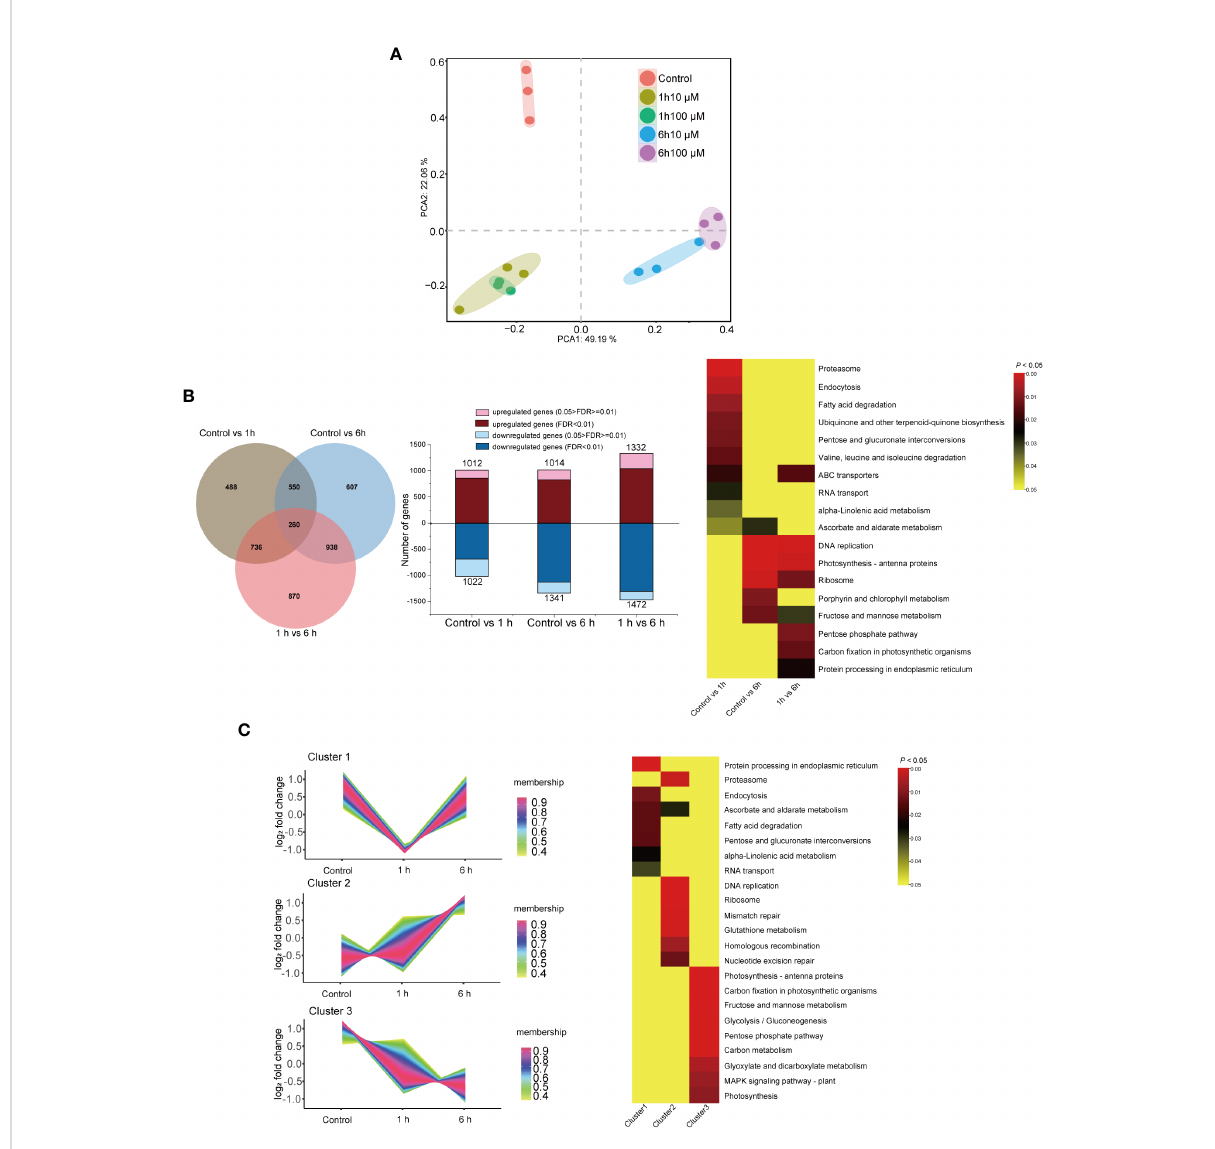
FIGURE 2 Transcriptional responses of Neoporphyra haitanensis to abscisic acid (ABA) treatment. (A) Principal components analysis (PCA) of the transcriptomic pro fi le of individual traits of N. haitanensis in response to ABA treatment. (B) A Venn diagram of differentially expressed genes (DEGs), the number of DEGs across treatments and a heatmap of signi fi cantly enriched pathways for DEGs. (C) Clusters of scaled transcript pro fi les of N. haitanensis following ABA treatment. Cluster memberships were determined by the similarities of objects measured with respect to subspaces. The corresponding heatmap describes signi fi cantly enriched KEGG pathways for each